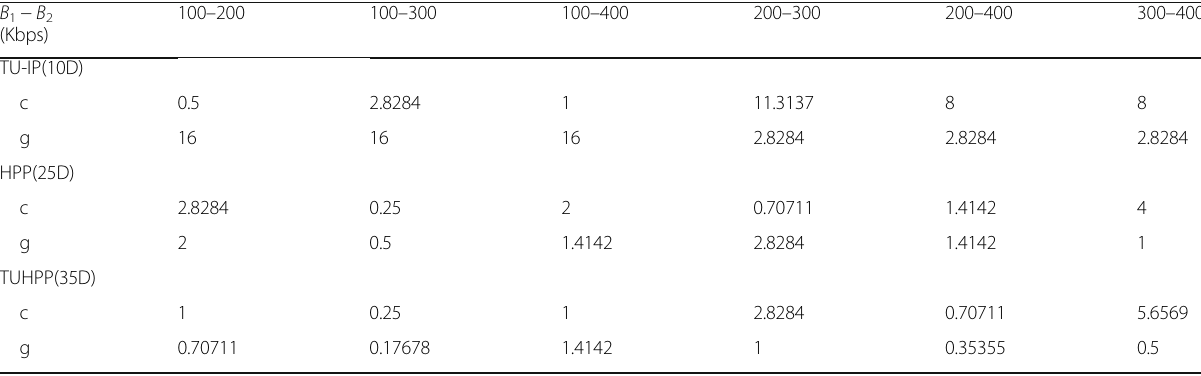
Table 8 The parameters used for training libSVM for feature set HPP [15], TUHPP, DCT136 [11], and TUDCT136 on CIF video